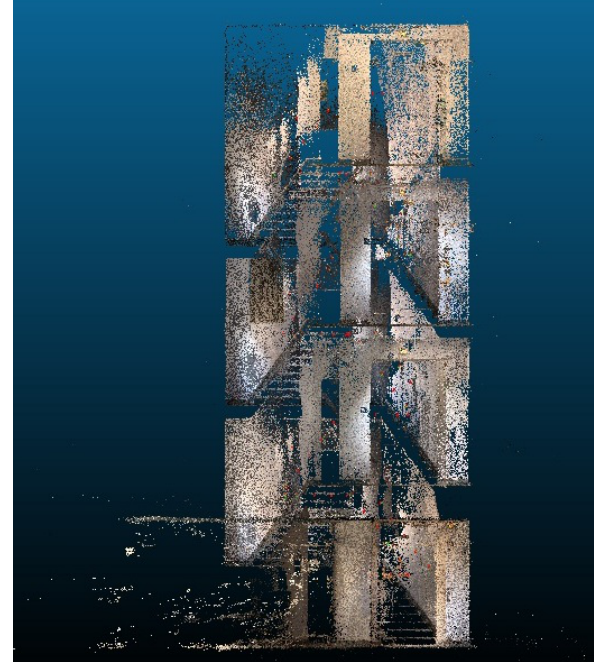
Figure 3: IBM sparse point cloud